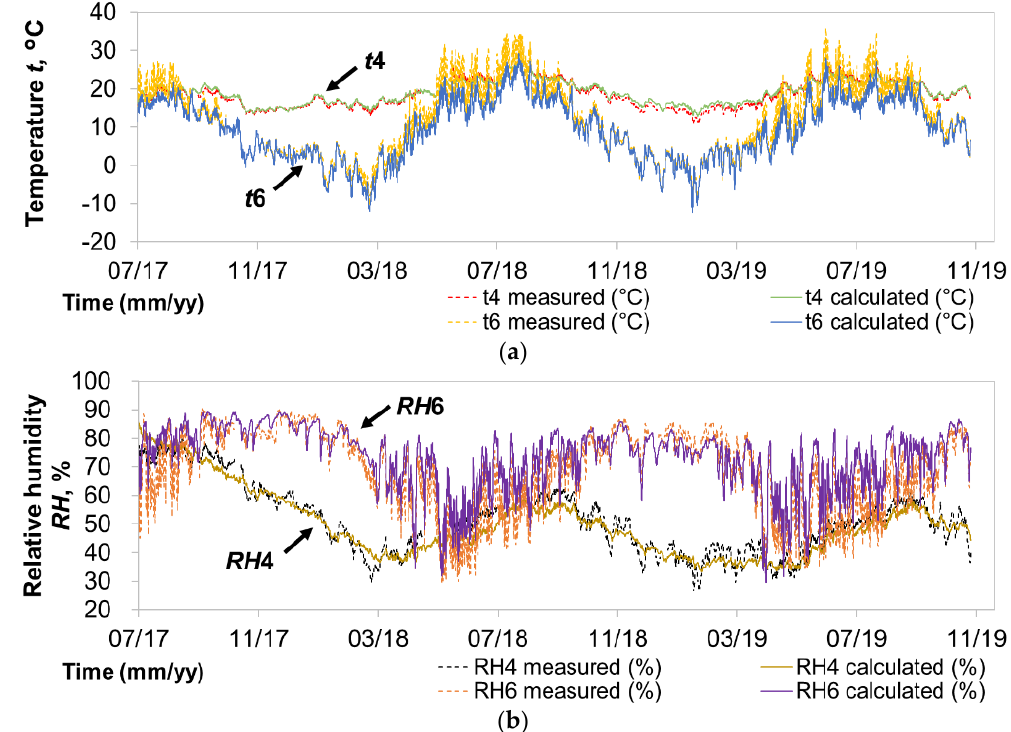
Figure 3. Measured and calculated temperature ( t ) and relative humidity ( RH ) in the timber frame insulation element, in point 4 and point 6. See Figure 1 for the measurement points. ( a ) Measurement points P4. ( b ) Measurement points P6.